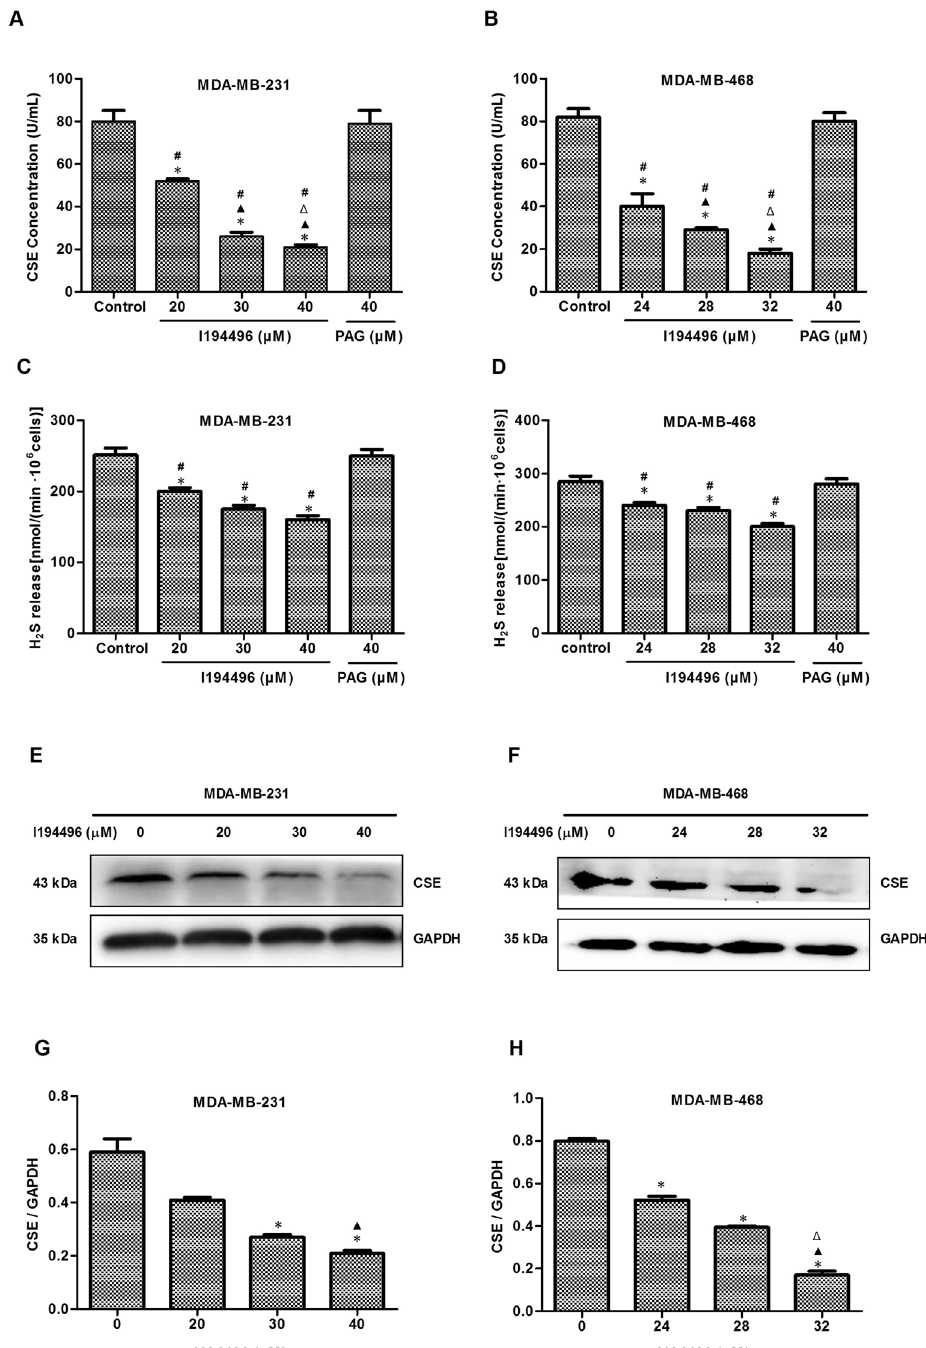
Figure 2. I194496 suppresses CSE/H 2 S system of TNBC cells. ( A ) The effect of I194496 on CSE concentration in MDA-MB-231 cells. *P < 0.05 vs 0 μM I194496 group. ▲ P < 0.05 vs 20 μM I194496 group. Δ P < 0.05 vs 30 μM I194496 group. # P < 0.05 vs PAG group. ( B ) The effect of I194496 on CSE concentration in MDA-MB-468 cells. *P < 0.05 vs 0 μM I194496 group. ▲ P < 0.05 vs 24 μM I194496 group. Δ P < 0.05 vs 28 μM I194496 group. # P < 0.05 vs PAG group. ( C ) The effect of I194496 on H 2 S release in MDA-MB-231 cells. *P < 0.05 vs 0 μM I194496 group. # P < 0.05 vs PAG group. (D) The effect of I194496 on H 2 S release in MDA-MB-468 cells. *P < 0.05 vs 0 μM I194496 group. # P < 0.05 vs PAG group. ( E , G ) The effect of I194496 on expression of CSE in MDA-MB-231 cells. *P < 0.05 vs 0 μM I194496 group. ▲ P < 0.05 vs 20 μM I194496 group. (F and H) The effect of I194496 on expression of CSE in MDA-MB-468 cells. *P < 0.05 vs 0 μM I194496 group. ▲ P < 0.05 vs 24 μM I194496 group. Δ P < 0.05 vs 28 μM I194496